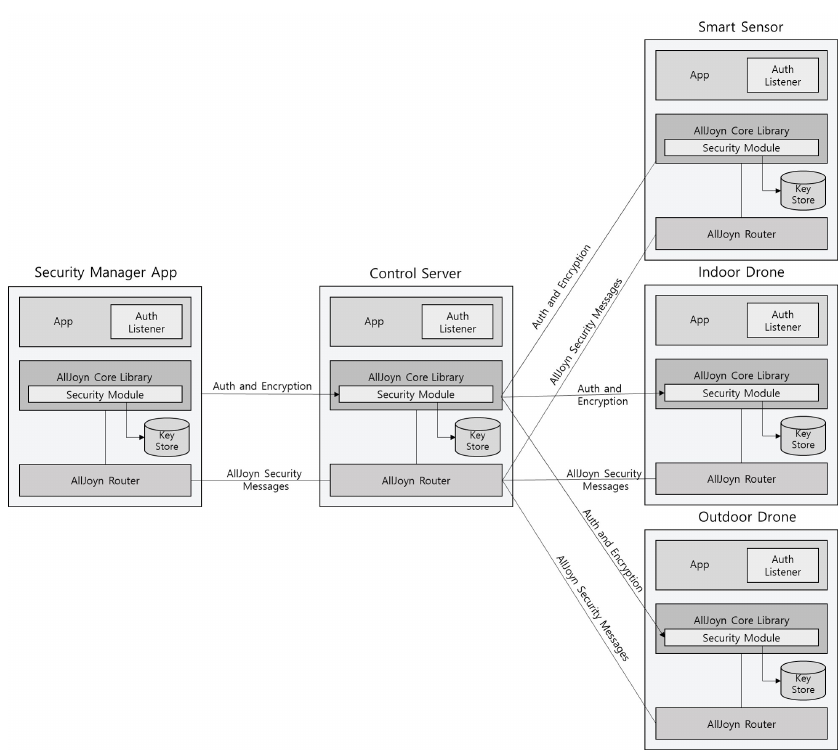
Figure 3. The security architecture of our system.